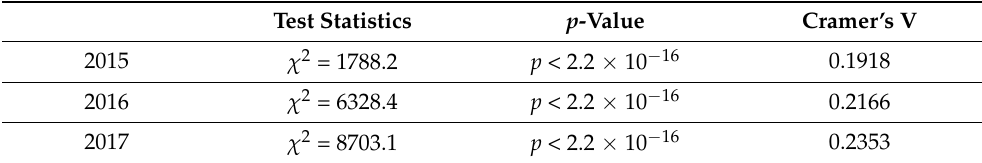
Table 10. Test results: The relationship between the allocated college and the students’ desired ranking of